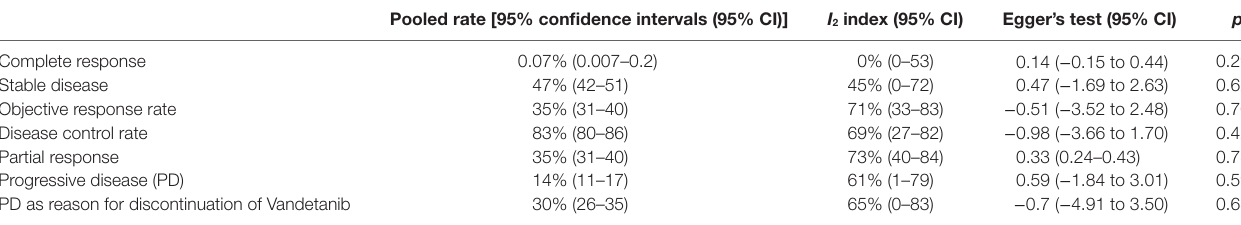
taBLe 3 | Results of meta-analysis of RECIST